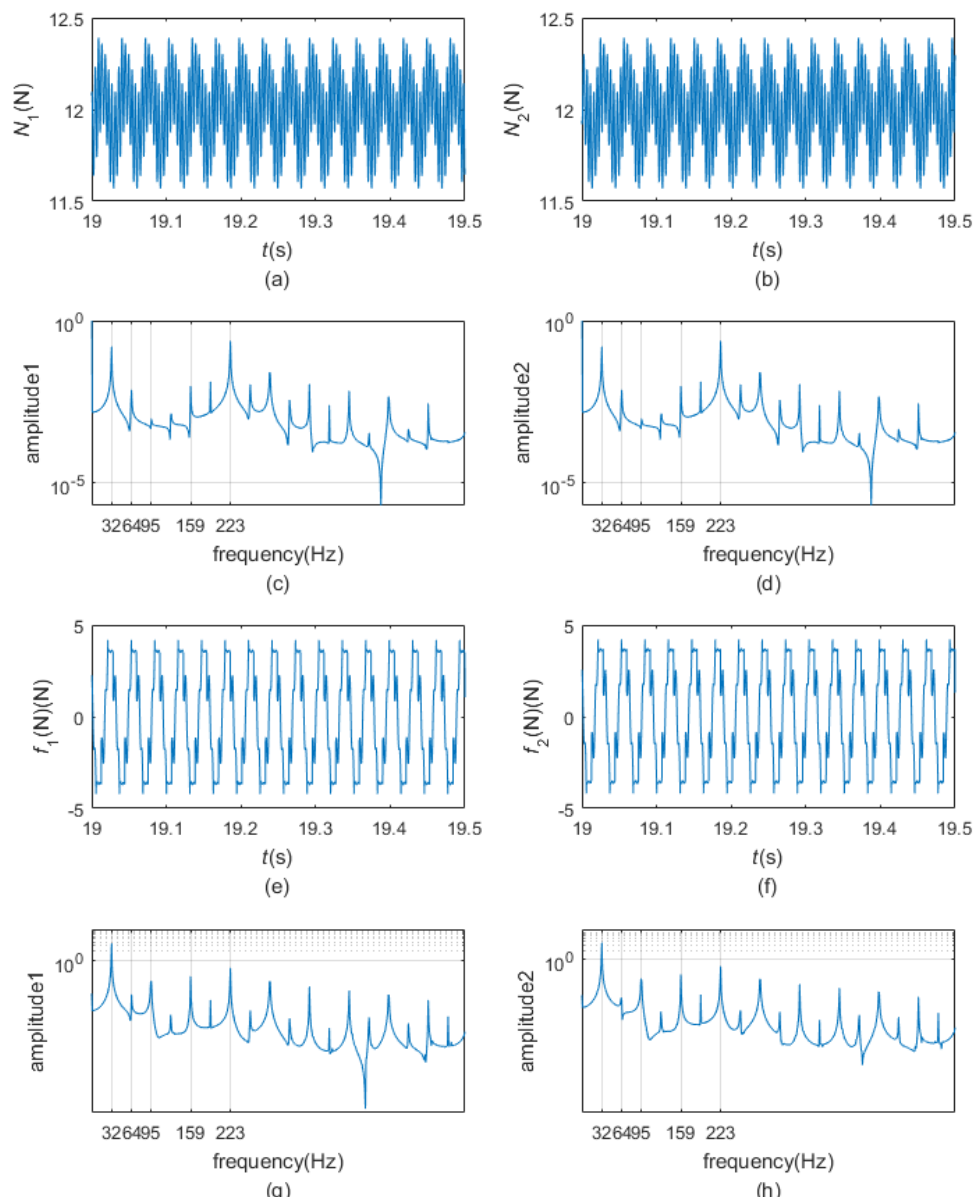
Figure 13. The normal contact forces and friction forces versus time t curves ( a , b , e , f ); and frequency spectrums of the normal contact forces and friction forces ( c , d , g , h ).